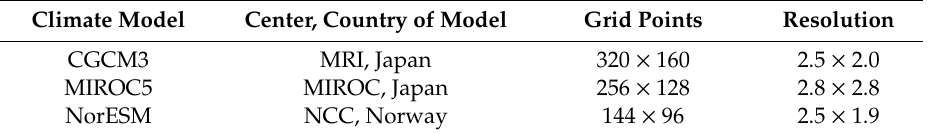
Table 3. Basic information on study models.